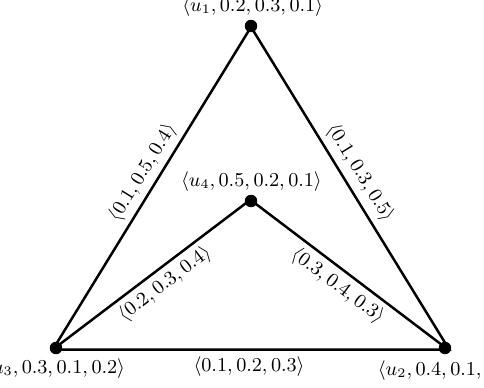
Figure 9. Single-valued neutrosophic graph Figure 9: SVNG